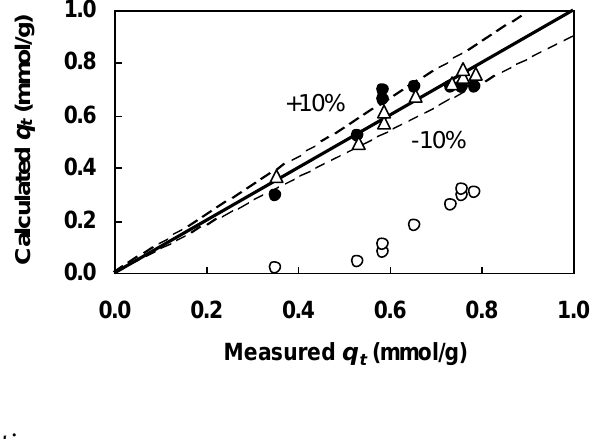
Figure 6. Comparison between the Figure 4 kinetic data and q Lagergren equation (Equation (7)) with the linear regression-derived parameters (open circles) and GA-generated parameters (filled circles) listed in Table 4. Also shown are q calculated from the n th order equation (Equation (10)) with the GA-derived parameters (triangles) given in Table